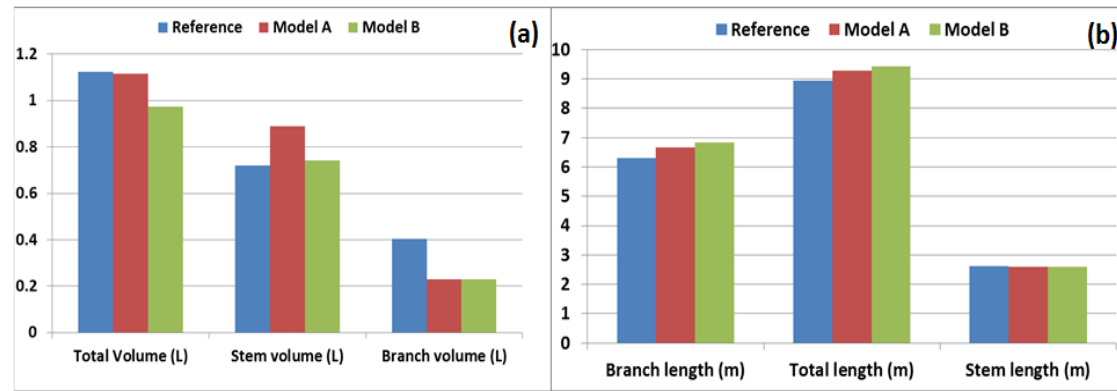
Figure 8. Comparison of the reference measurement and the QSM model after the third cut from two independent TLS scans (denoted as A and B): ( a ) total, stem, and branch volume ( b ) branch, total, and stem